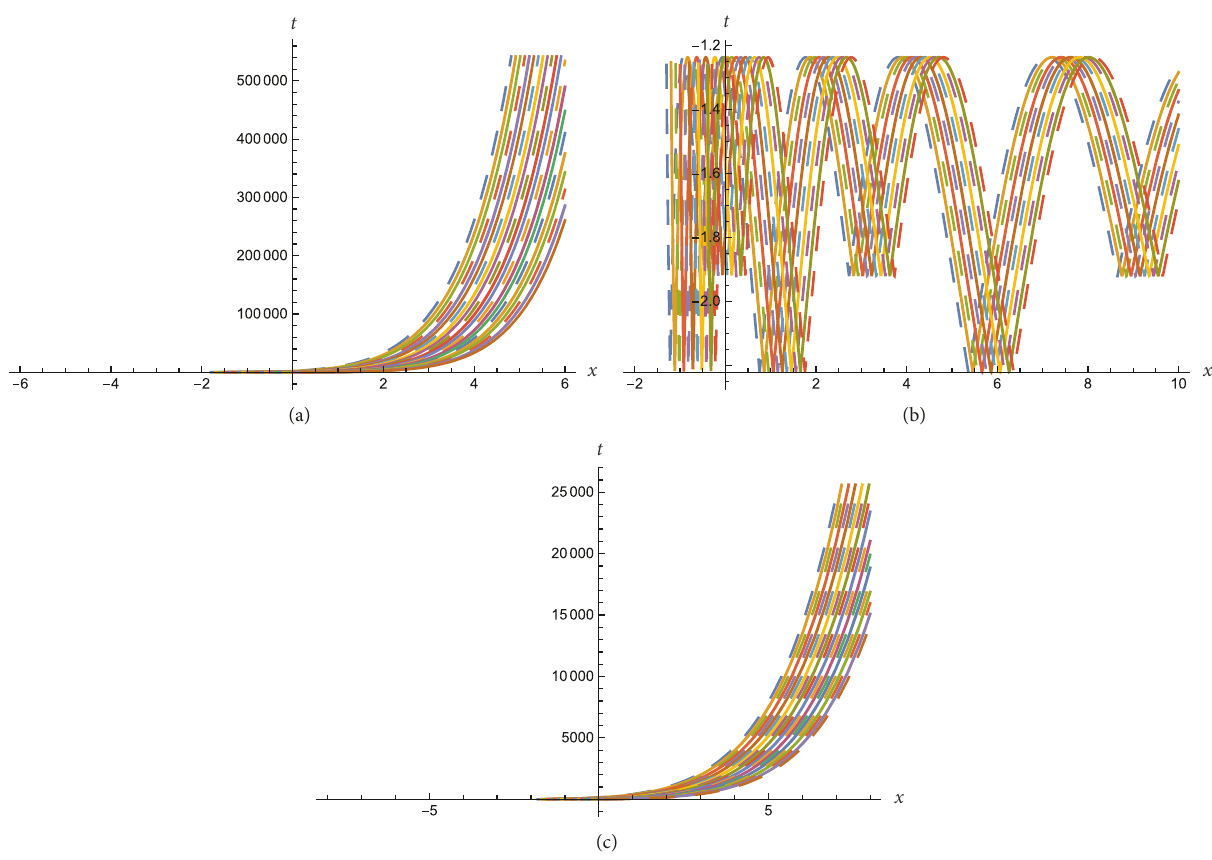
Figure 1: Plot of the exact traveling wave solutions of (a) rational solitary wave solution (11) with parameters 𝑎 1 = 1; 𝛼 = 0.6;𝑙 0 = 0.7;𝑙 1 = 9;𝑙 = 20;𝜅 = 0.7; 𝑐 = 0.1; 𝑦 = 0.8 ; (b) periodic solitary solution (13) plotted at 𝑎 2 0.8 ; and (c) soliton solitary solution (15) plotted at 𝑎